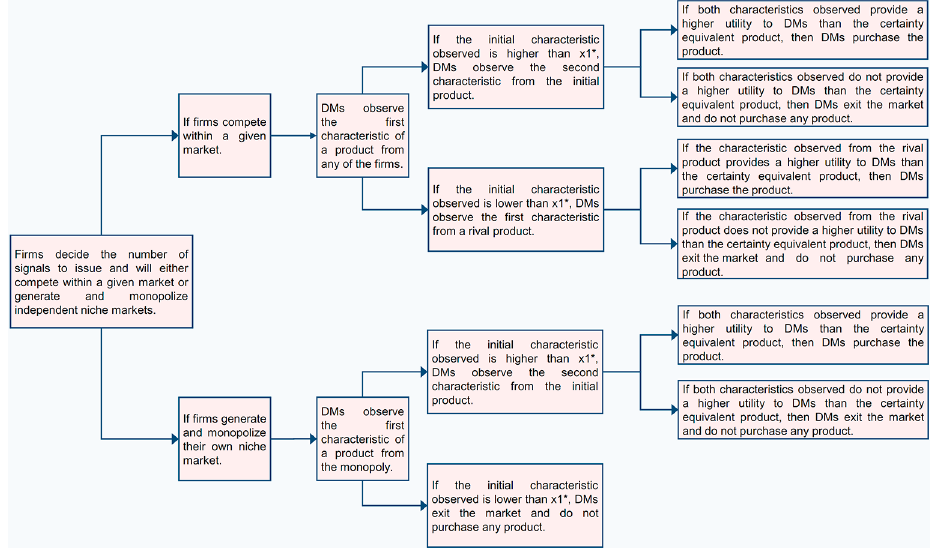
Figure 9. Information acquisition process within a developing product